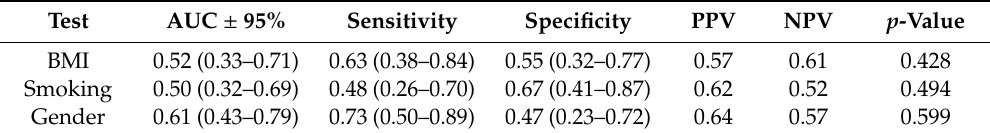
Table 7. Confounding factors: Wolf eNose